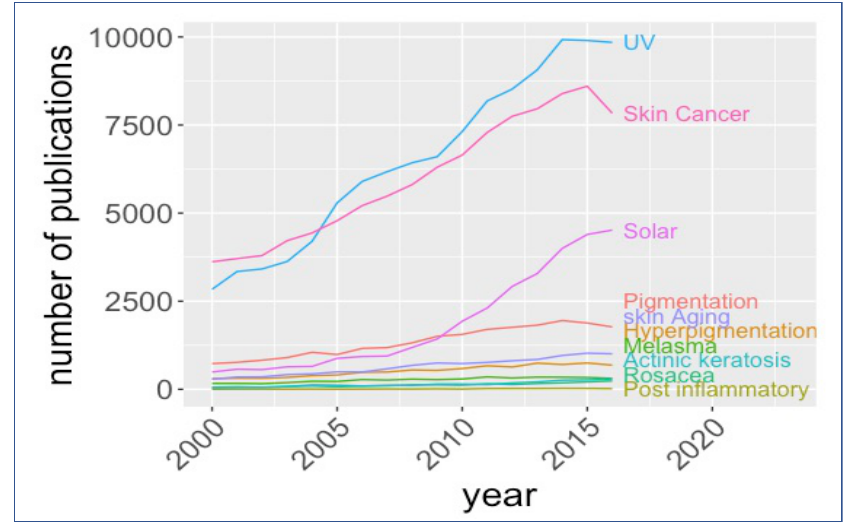
Figure 2. Distribution of the number of publications for more common skin